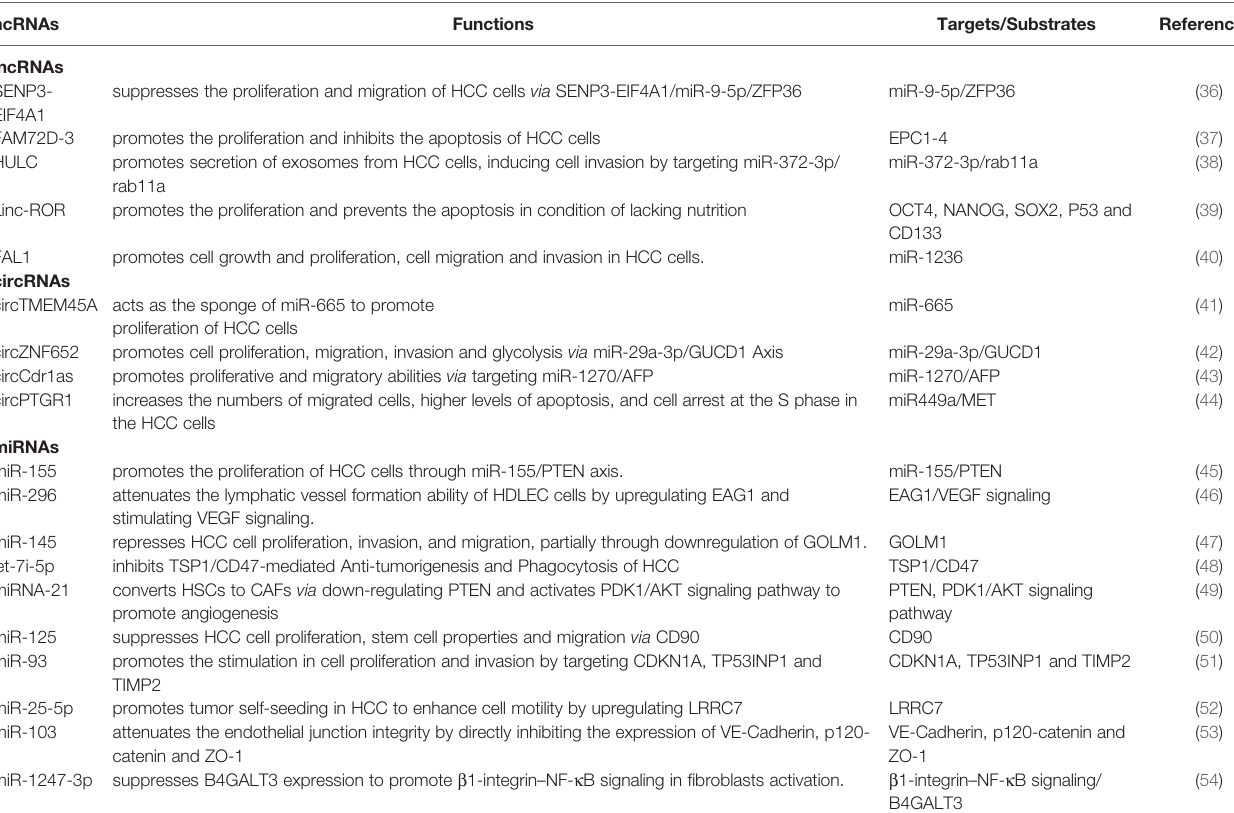
TABLE 1 | Exosomal ncRNAs in